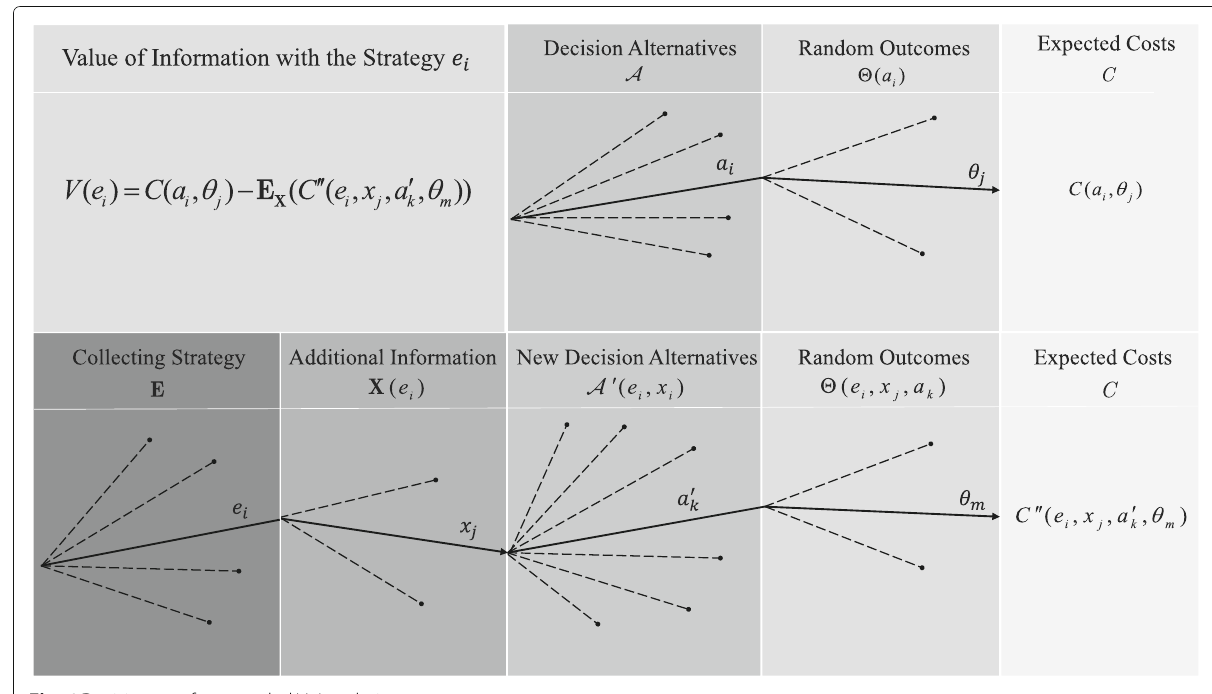
Fig. 6 Decision tree for extended VoI analysis